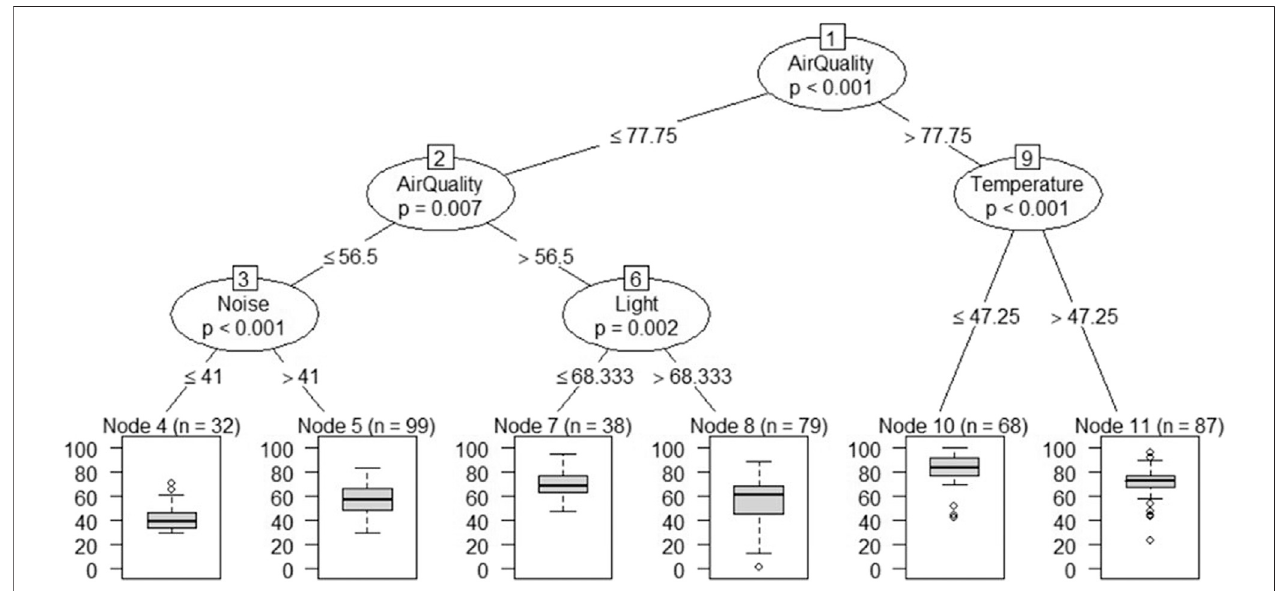
FIGURE 9 | Decision tree diagram: environment and mood